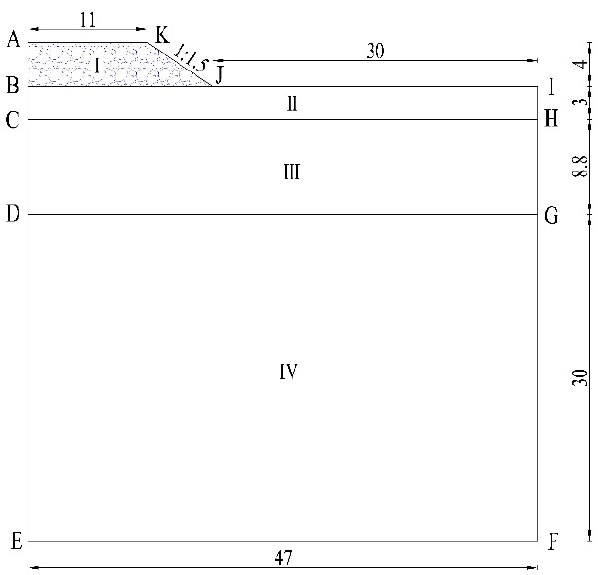
Figure 2. Geometric model and calculation unit division of the subgrade structure. (Unit: m).